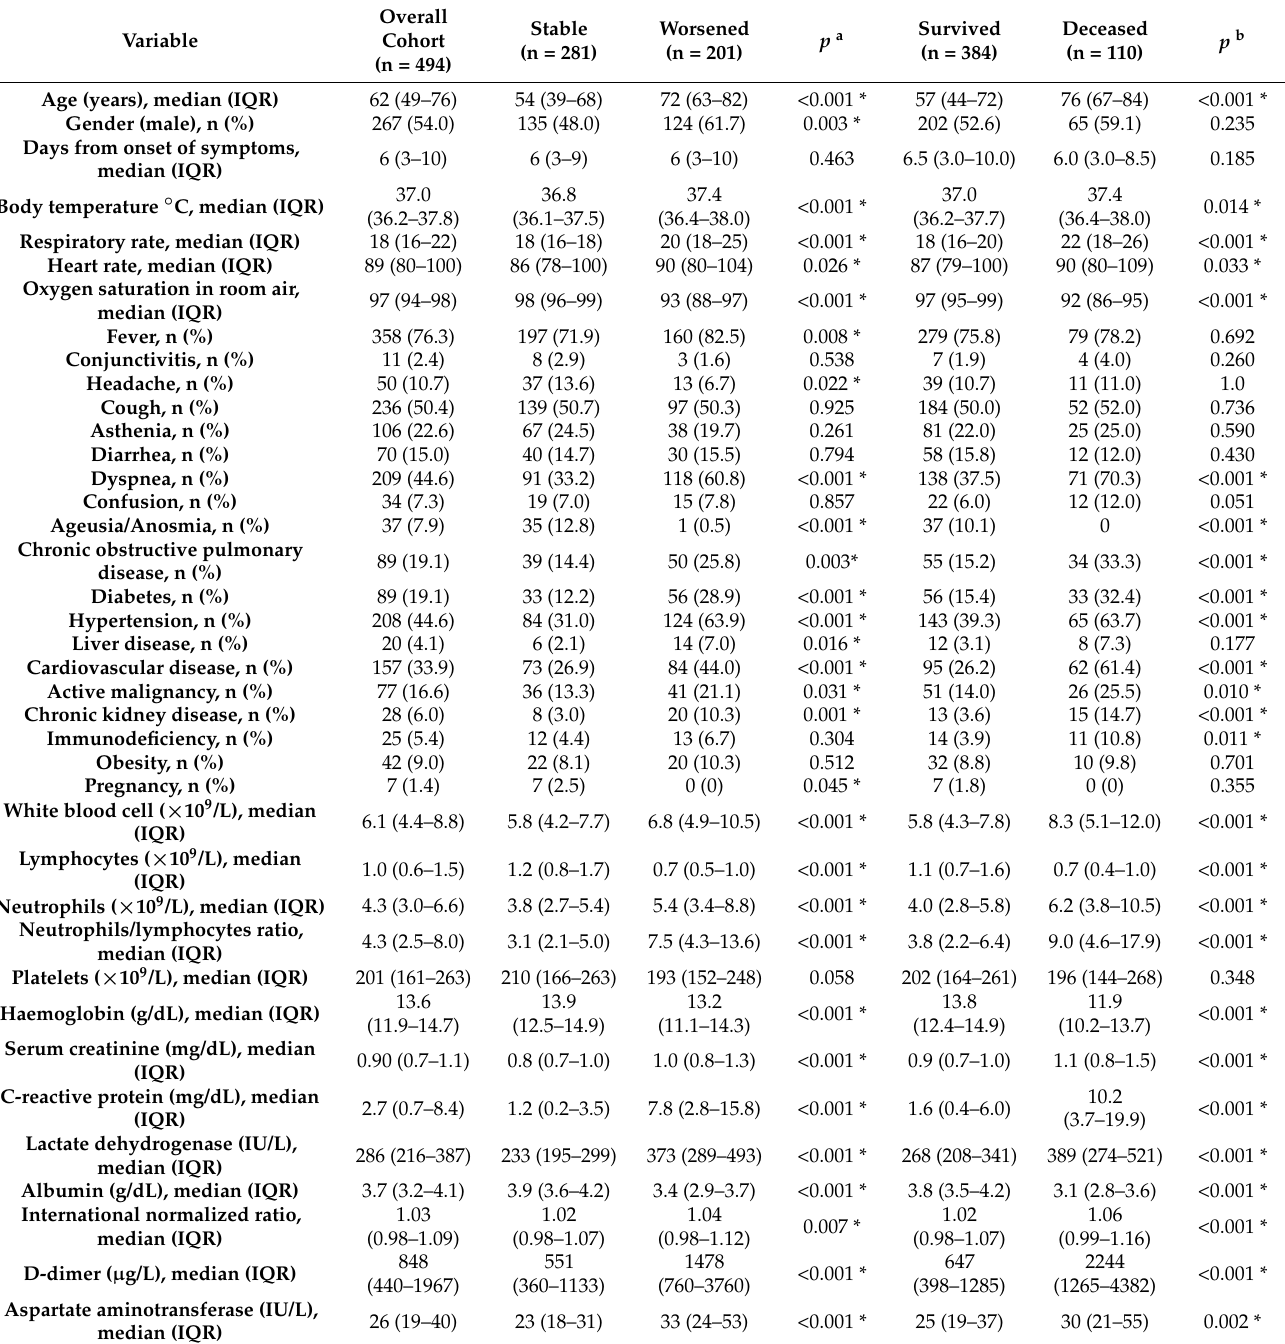
Table 1. Clinical and laboratory characteristics of the derivation cohort according to seven-day re-evaluation and